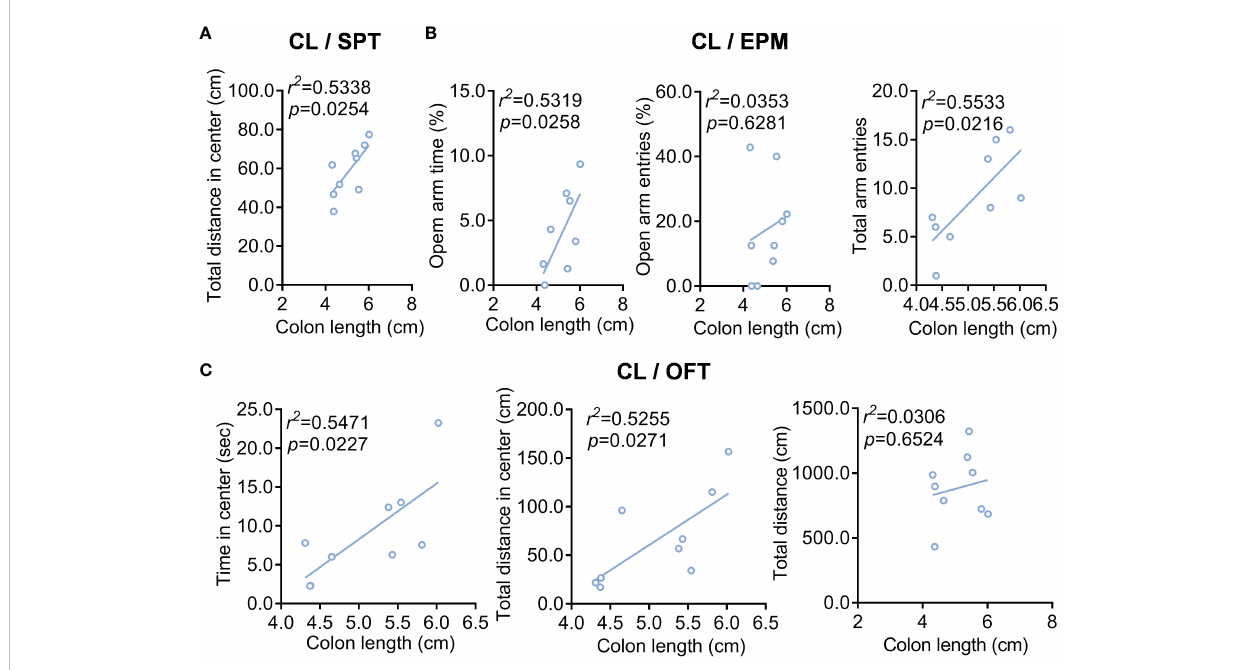
FIGURE 3 The correlation analysis of colonic length with depression/anxiety-related behaviors in the DSS/stress-treated mice. (A) Colonic length (CL)/SPT. (B) Colonic length (CL)/EPM. (C) Colonic length (CL)/OFT.